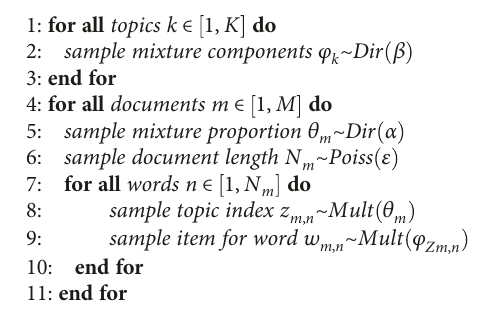
Algorithm 1: LDA document generation